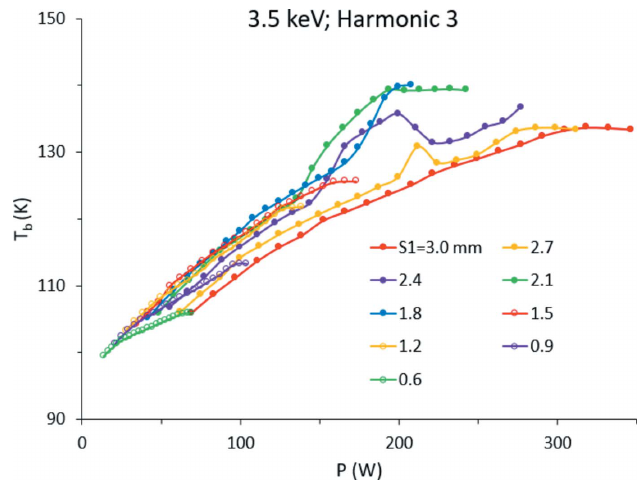
Figure 8 Steady state values of T b versus calculated power for E = 3.5 keV and 5.0 keV and different slit size.